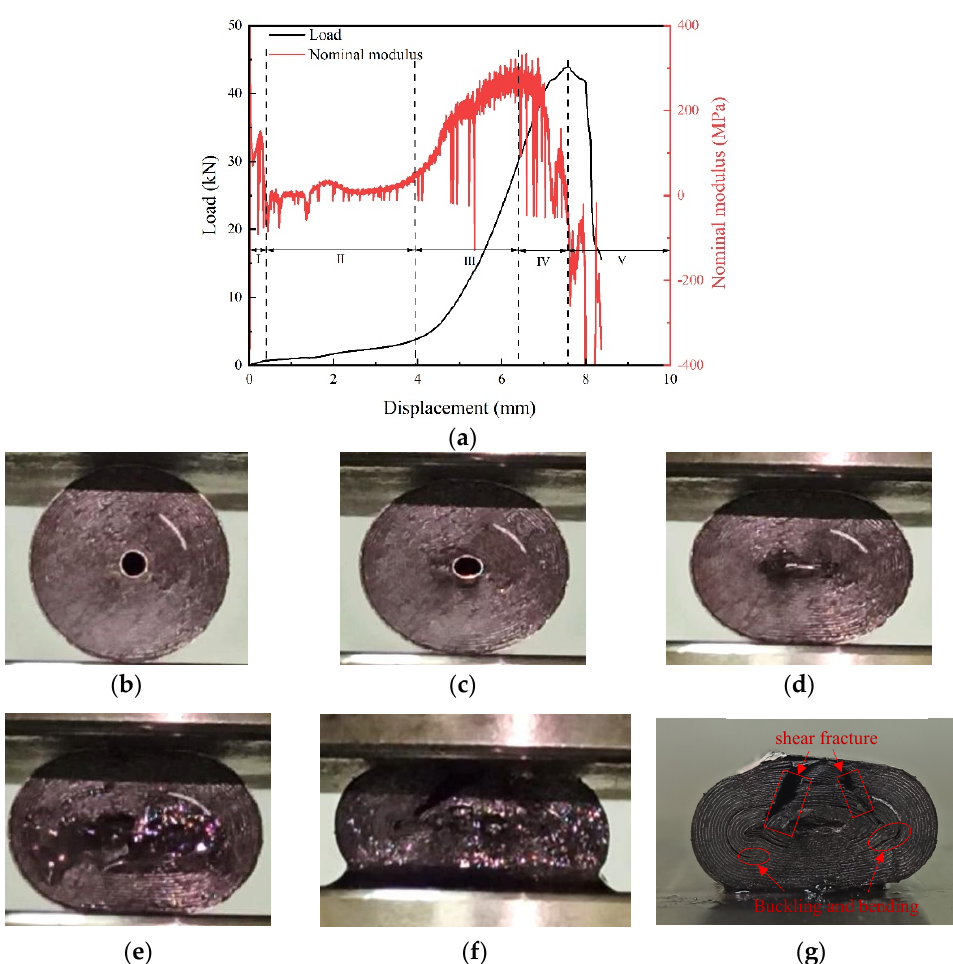
Figure 5. Radial compression process of power battery: ( a ) load, nominal modulus − displacement curve; ( b ) 0.4 mm deformation of Stage I; ( c , d ) 1.5 mm and 3.0 mm deformations diagram of Stage II; ( e ) 6.39 mm deformation diagram of Stage III; ( f ) 7.56 mm deformation diagram of Stage IV; ( g ) deformation diagram of Stage V.